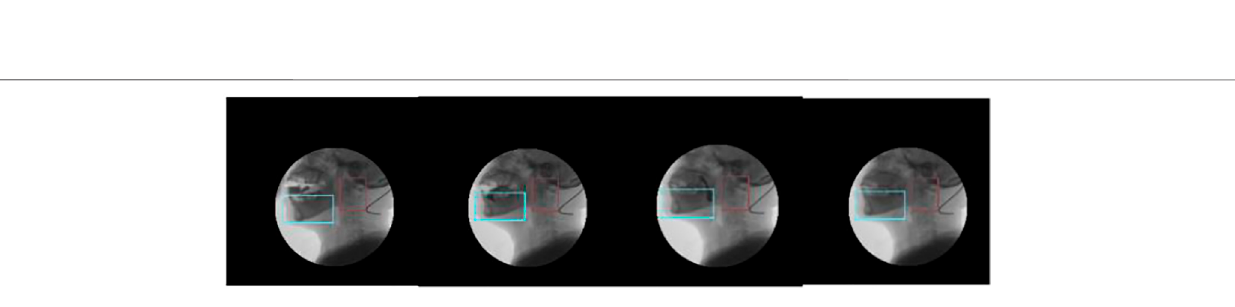
FIGURE 11 | Tracking the chin and the upper part of the